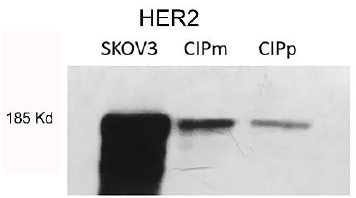
Figure 1. Specific bands corresponding to 185KD HER2 are present in canine cell lines (CYPp and Specific bands corresponding to 185KD HER2 are present in canine cell lines CYPm) co-migrating with human HER2 over-expressed in human SKOV3 cell line. (Original figure: (CYPp and CYPm) co-migrating with human HER2 over-expressed in human SKOV3 cell line. Figure S1). (Original figure: Figure